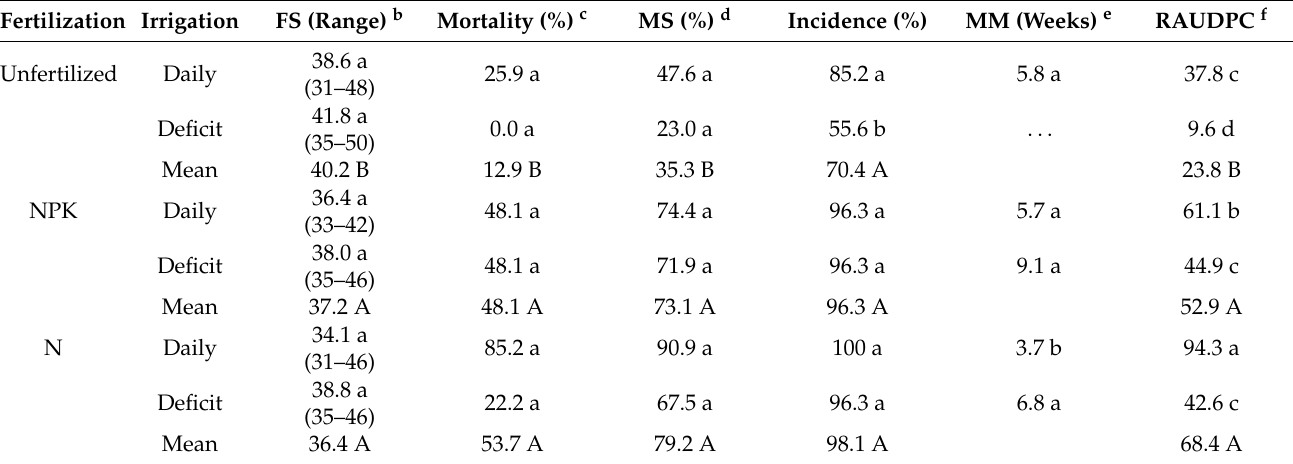
a Trees were surveyed periodically for symptom development over 11 months (February 2015 to January 2016). The values listed in columns followed by the same letter were not significantly different at p = 0.05. b FS = The time from orchard establishment to the onset of disease symptoms. Differences were estimated according to the log rank test. c Mortality (%) = Differences were estimated according to Fisher’s protected (LSD) test. d MS = Mean severity in percentage. Differences were estimated according to Fisher’s protected (LSD) test. e MM = Time from symptom onset to plant death. Differences were estimated according to the log rank test. f RAUDPC = Relative area under disease progress curve expressed as a percentage of maximum theorical curve.